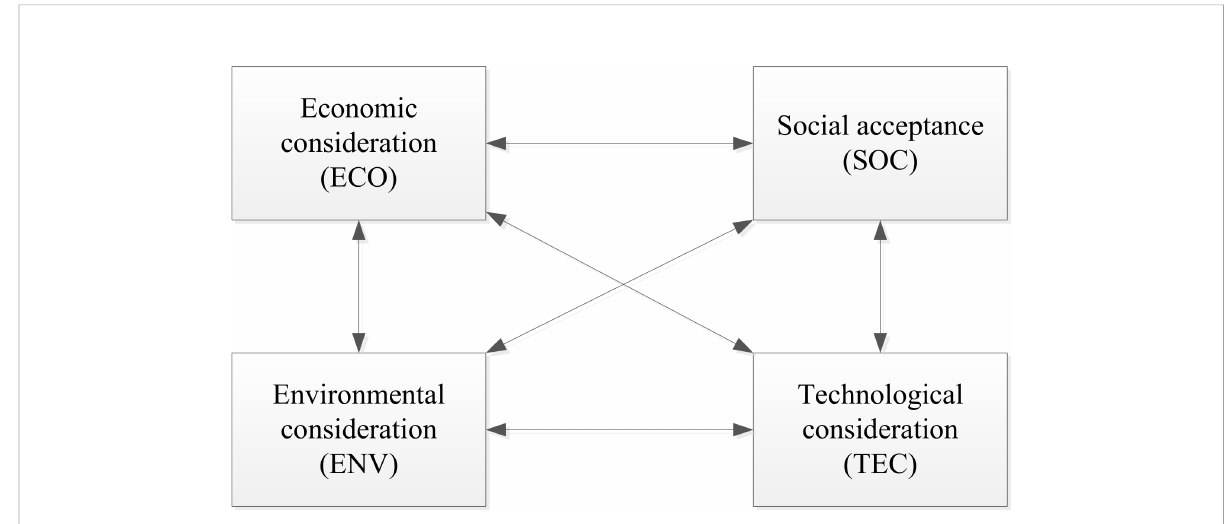
FIGURE 4 Diagram re fl ecting the interconnection relationships between the major criteria (Ma et al.,